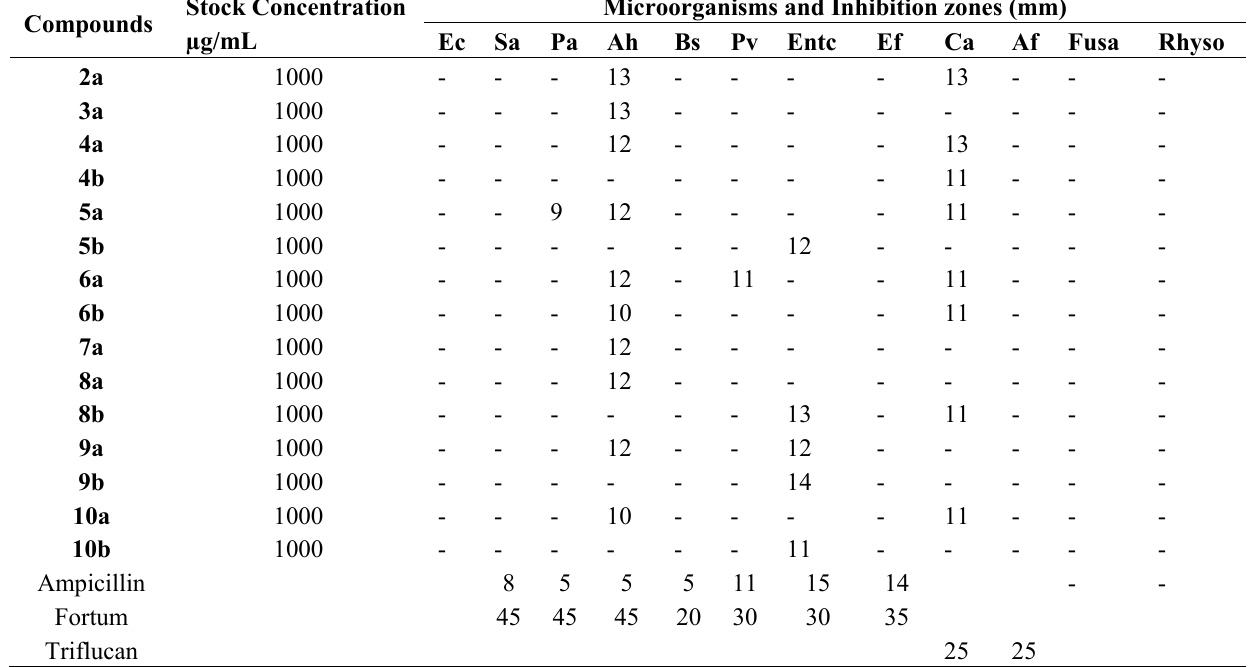
Table 2. Screening for antimicrobial activity of the